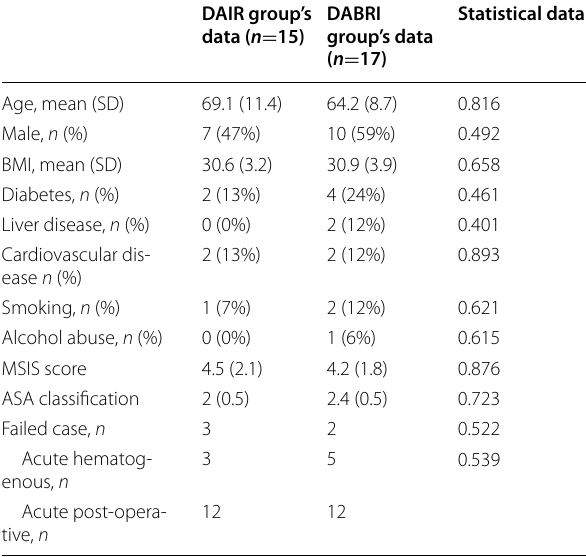
Table 3 Two-weeks after systemic antibiotic therapies in DAIR